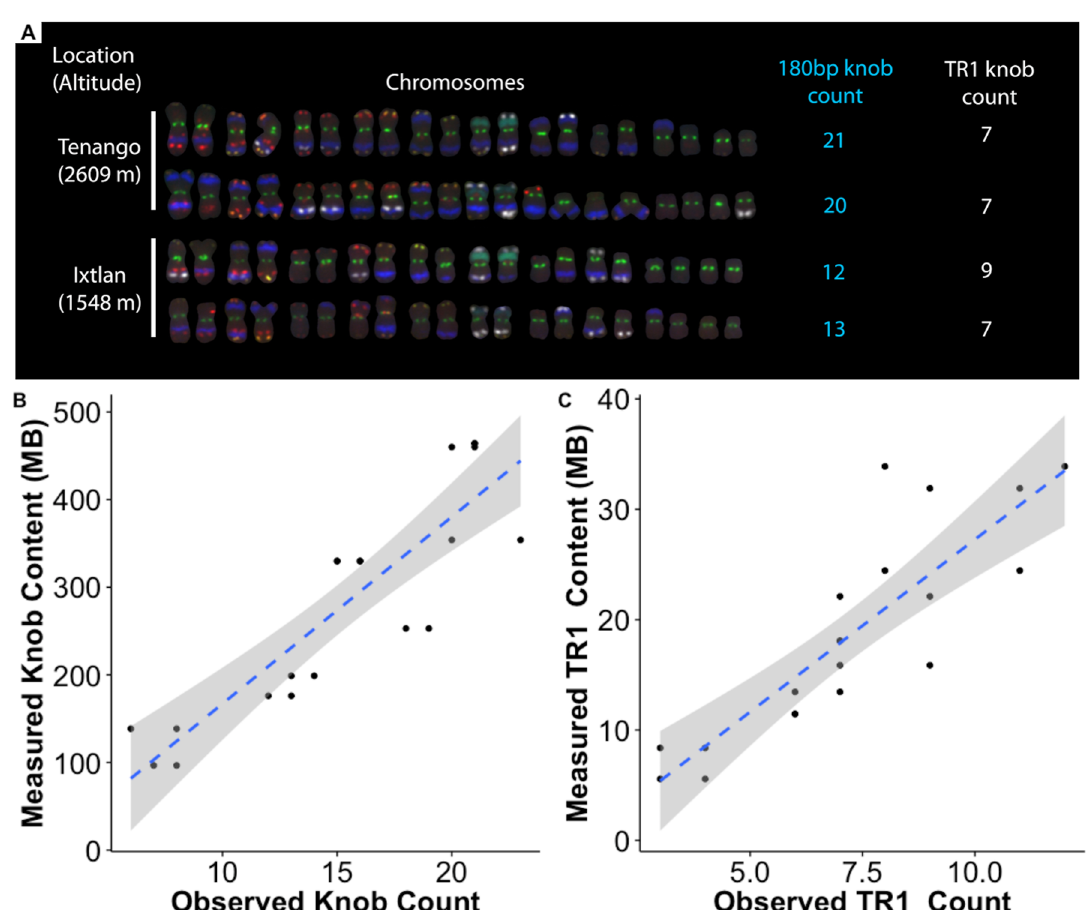
Fig 2. Knob content in highland teosinte estimated using FISH and low-coverage sequencing. (A) FISH from four Z. mays ssp. mexicana individuals, sampled from the highest and lowest altitude populations. Counts of cytological 180bp (blue) and TR1 (white) knobs are shown to the right of each individual. Other stained repeats are CentC and subtelomere 4-12-1 (green), 5S ribosomal gene (yellow), Cent4 (orange), NOR (blue-green), and TAG microsatellite 1-26-2 and subtelomere 1.1 (red). For further staining information, see [40]. (B) Plot of the population-level correlation between 180bp knob counts and sequence abundance for 20 mexicana individuals. 180bp knob r = 0.88, TR1 knob r =